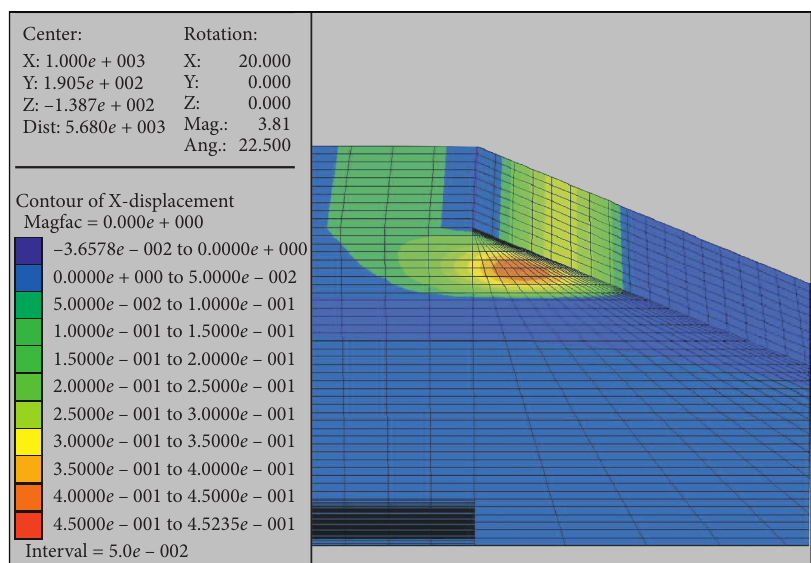
Figure 13: Horizontal displacement after slope excavation in the presence of hydraulic